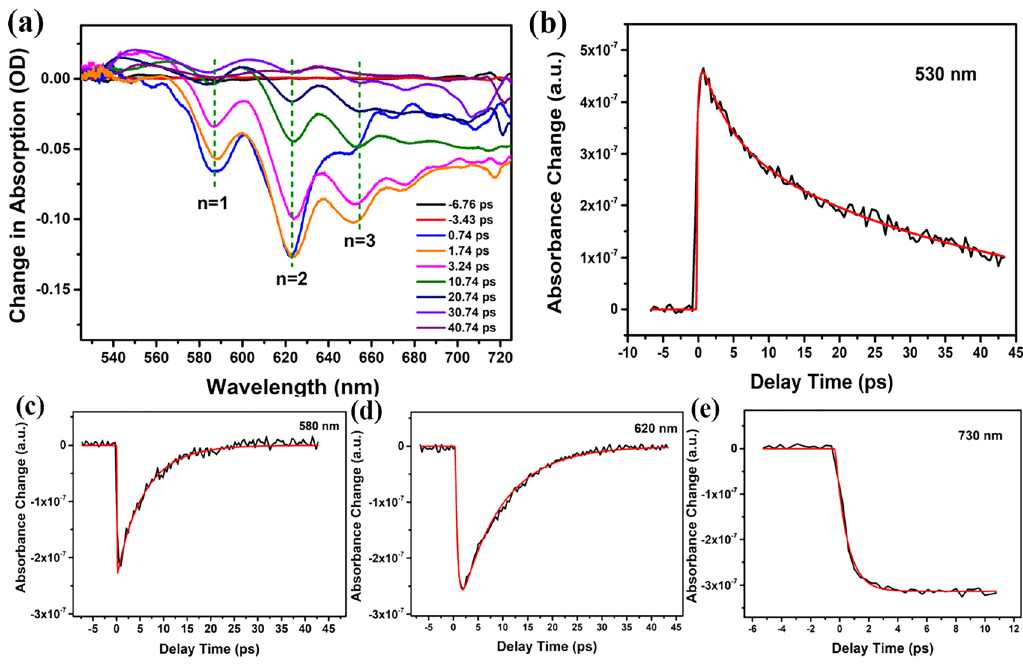
Figure 4: (a) TA spectra obtainedfor thin film ACI 3 ina 50 ps timewindow,(b – e) TA decay traces andcorresponding fi tsobtained for thin fi lm ACI 3 at 530 nm (b), 580 nm (c), 620 nm (d) and 730 nm (e) in a 50 ps time window.